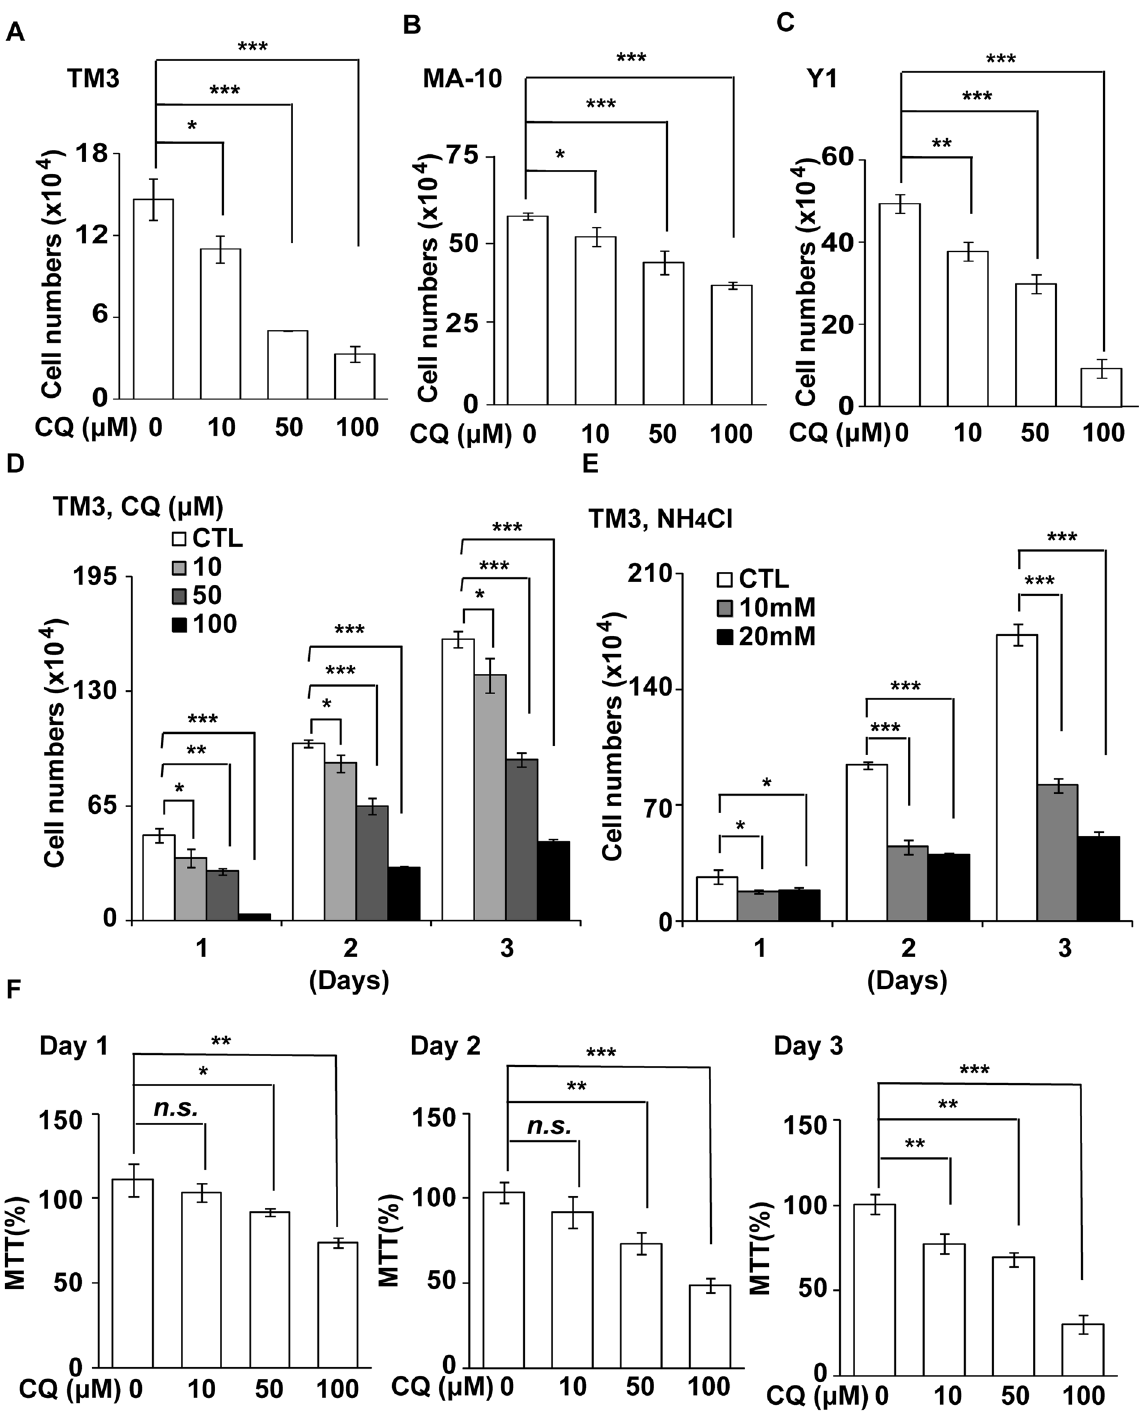
Figure 1. Lysosomal inhibitors reduces steroidogenic cell growth in vitro . ( A – C ) Treatment of chloroquine (CQ, at concentration of 10, 50, or 100 μ M) for 24 h reduces the growth of TM3 (A), MA-10 ( B ), and Y1 ( C ) cell lines. ( D , E ) Treatment of TM3 cells with CQ ( D ) or NH 4 Cl ( E ) at different concentrations for different time points inhibits cell growth. CTL: control. ( F ) CQ inhibits TM3 cell growth in dose- and time- dependent manners as shown by MTT assay. n.s.: no significance; * P < 0.05; ** P < 0.01; *** P <